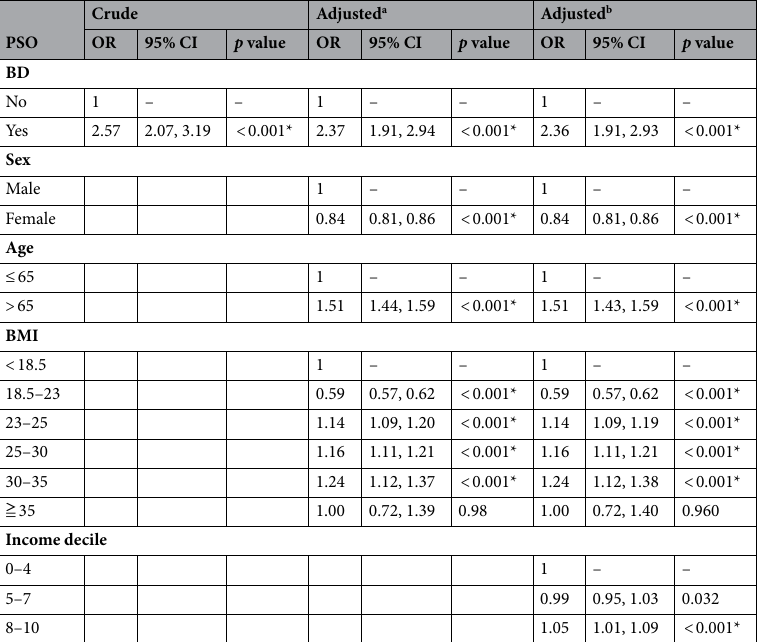
Table 4. Prevalence of psoriasis by Behçet disease status, with subgroup analyses by sex, age, and income levels. BD, Behçet disease; PSO, psoriasis; OR, odds ratio; CI, confidence interval (95% confidence intervals). a Adjusted result by sex (male and female) and age (≤ 65 and > 65). b Adjusted result by sex (male and female),